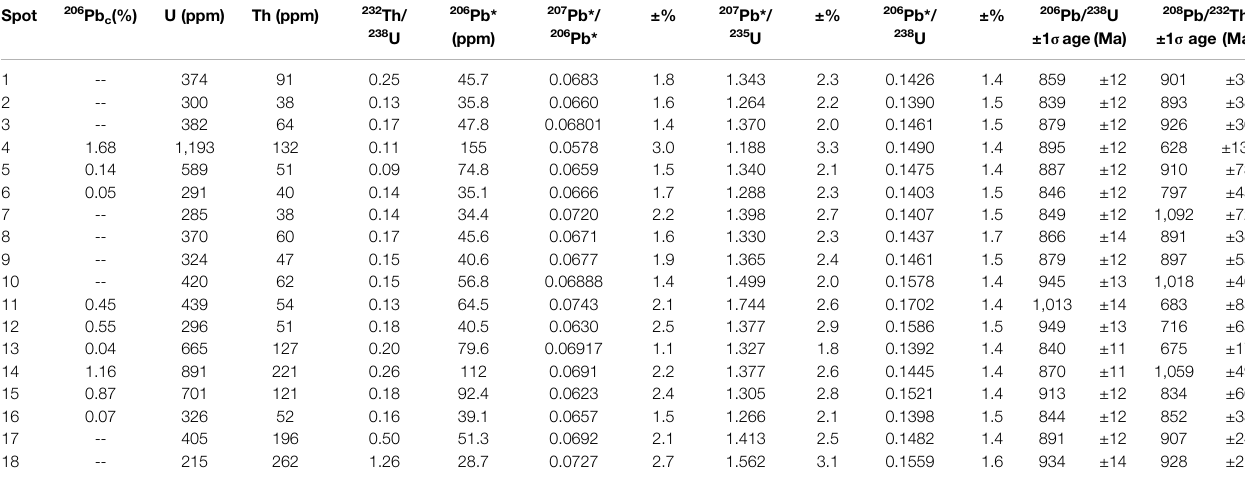
TABLE 1 | SHRIMP Zircon U-Pb data of the granite dyke (Sample 1725) related to Dongxicun Kaolin deposit.